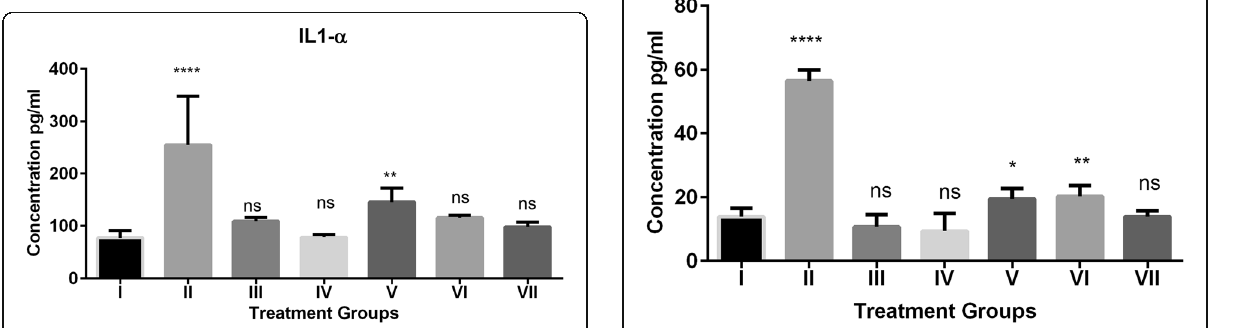
Fig. 3 Effect of grapefruit juice (GFJ) and aripiprazole (ARI) on oxidative stress induced by H 2 O 2 by IL-2 levels. IL-2 concentration is expressed as pg/ml (n = 10), The treated groups were compared to control group. **** P < 0.0001, ** P < 0.01, * P < 0.1, ns: non-significant. # Group I: Control; Group II: H2O2 treated; Group III; ARI treated; Group IV GFJ treated; Group V: GFJ and H 2 O 2 treated; Group VI; ARI and H 2 O 2 treated; Group VII; ARI, GFJ and H 2 O 2